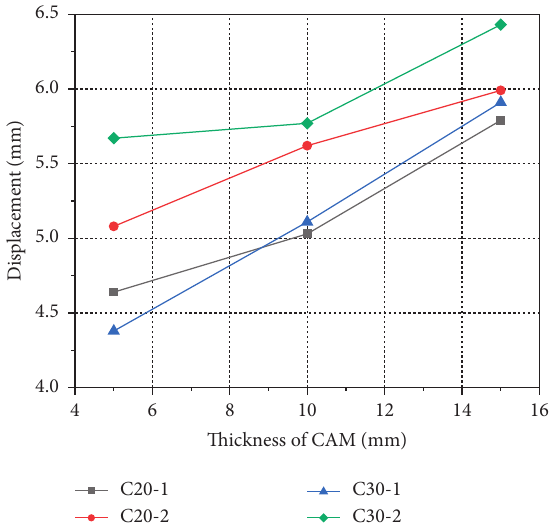
Figure 7: The effects of CAM thickness on vertical displacement.